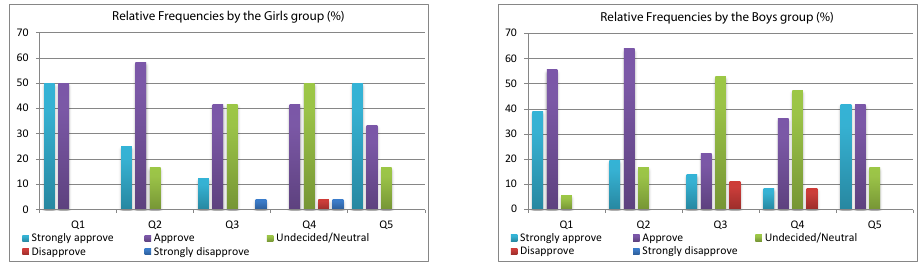
Figure 8: Relative frequency graphs of the questionnaire responses by